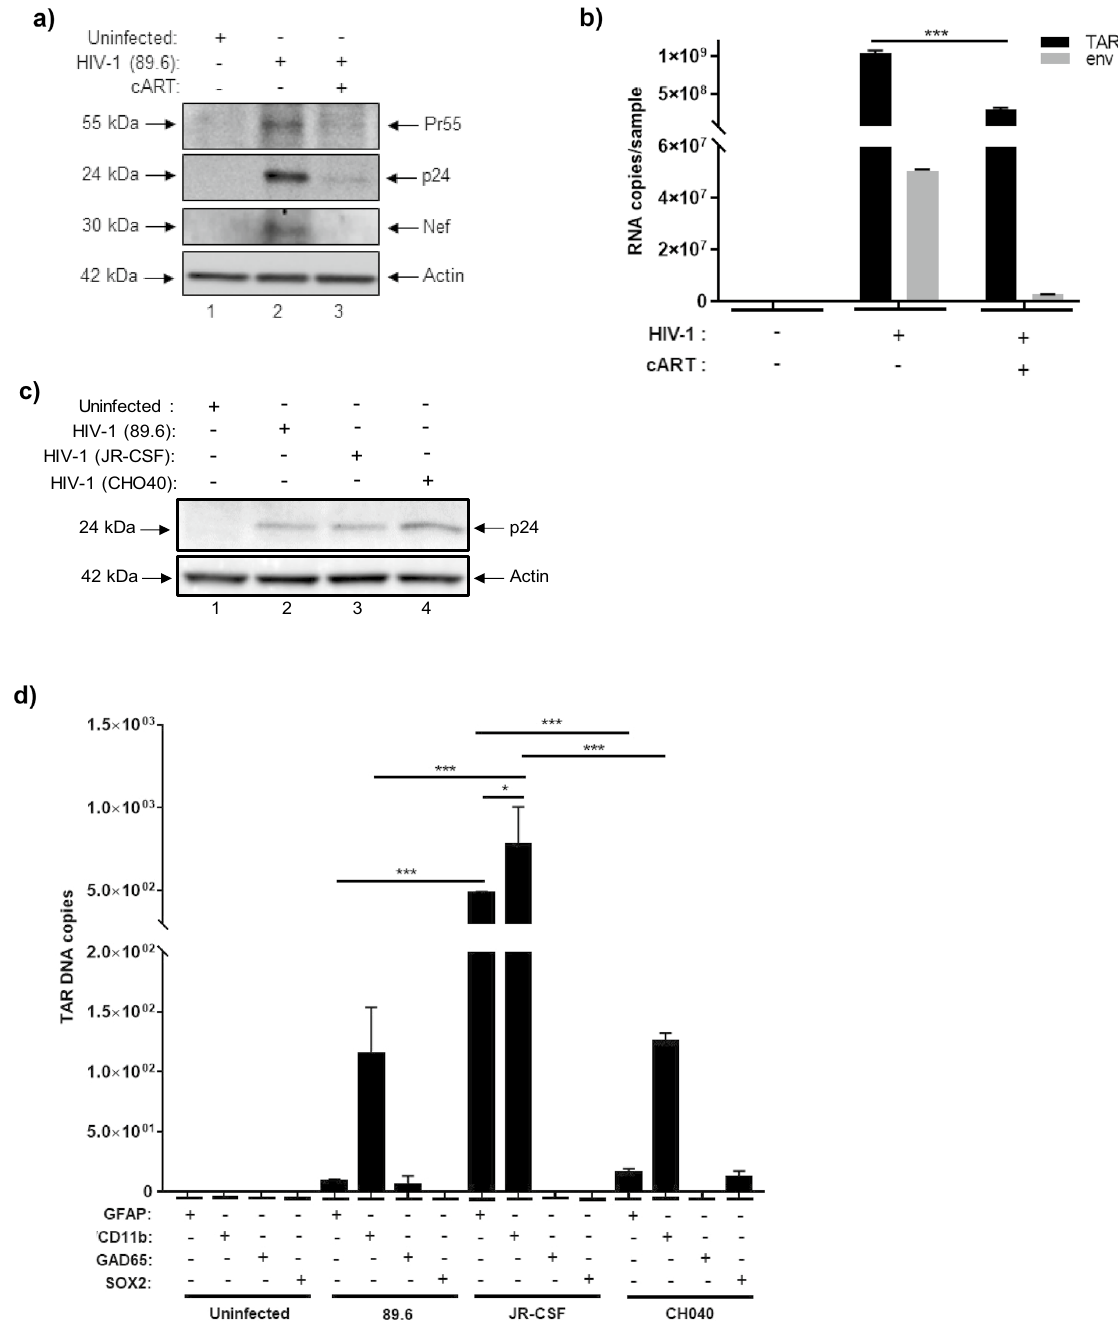
Figure 2. HIV-1 infection of NPC-derived neurospheres. Differentiated neurospheres were exposed to dual-tropic HIV-1 89.6, JR-CSF, or CHO40 (MOI:10). (a) Western blot was performed to examine the relative expression of Pr55, p24, and Nef in HIV-1 89.6 neurospheres cultured with or without cART (lamivudine, tenofovir disoproxil fumarate, emtricitabine, indinavir) after fourteen days. (b) RT-qPCR was performed to examine the relative copy numbers of TAR and env RNA in HIV-1 89.6 neurospheres with or without cART after fourteen days. n = 3. ***p < 0.0001. (c) Western blot was performed to compare the relative expression of p24 in HIV-1 89.6, JR-CSF, and CHO40 infected neurospheres after seven days. (d) Neurospheres were gently disaggregated and immunoprecipitation was performed using antibodies specific for astrocytes (GFAP), microglia-like cells (CD11b), neurons (GAD65), and NSCs (SOX2) followed by direct PCR to quantify copies of TAR DNA in different cellular subpopulations of HIV-1 89.6, JR-CSF, and CHO40-infected neurospheres. n = 3. * p < 0.05, *** p < 0.0001. Differentiated neurospheres were treated with IL-34 (100 ng/mL), M-CSF (25 ng/mL), TGFβ-1 (50 ng/mL) every other day for a period of seven days and were then exposed to dual tropic HIV-1 89.6 for a period of fourteen days with or without cART (lamivudine, tenofovir disoproxil fumarate, emtricitabine, indinavir). (e) Western blot was performed to examine the relative expression of viral proteins (Pr55, p24, Nef), microglia markers (IBA-1, CD11b, CD45), and apoptotic proteins (PARP-1, BAD). (f) RT-qPCR was performed to quantify the relative copy numbers of TAR and env RNA. n = 3. *** p <